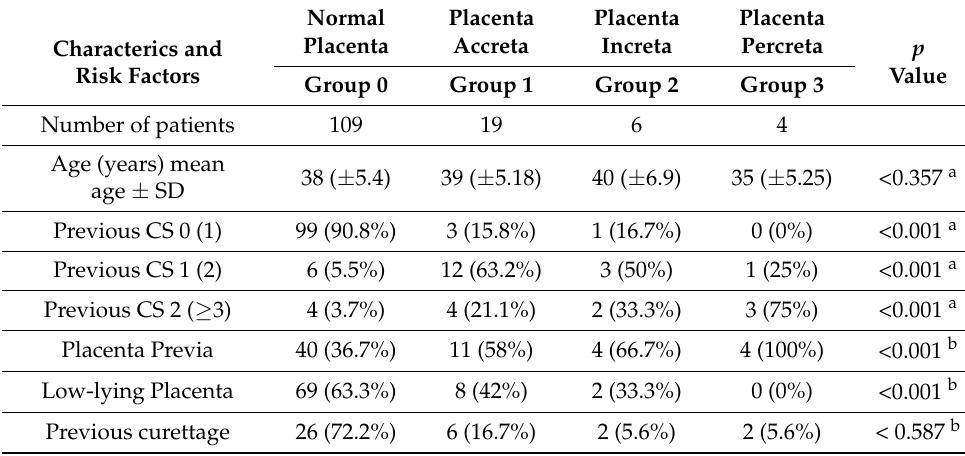
Table 2. Patients’ characteristics and risk factors for PAS.